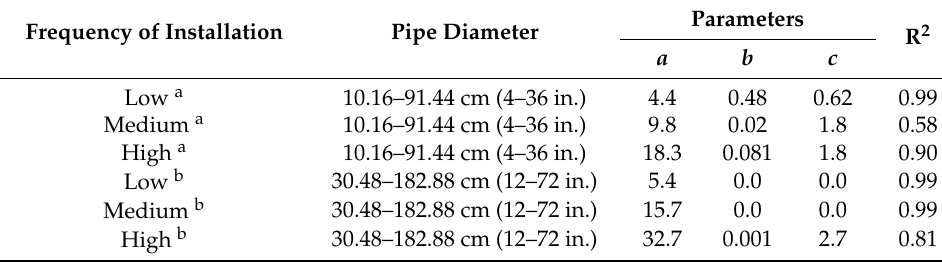
Table 4. Valve construction cost parameters based on Clark et al.